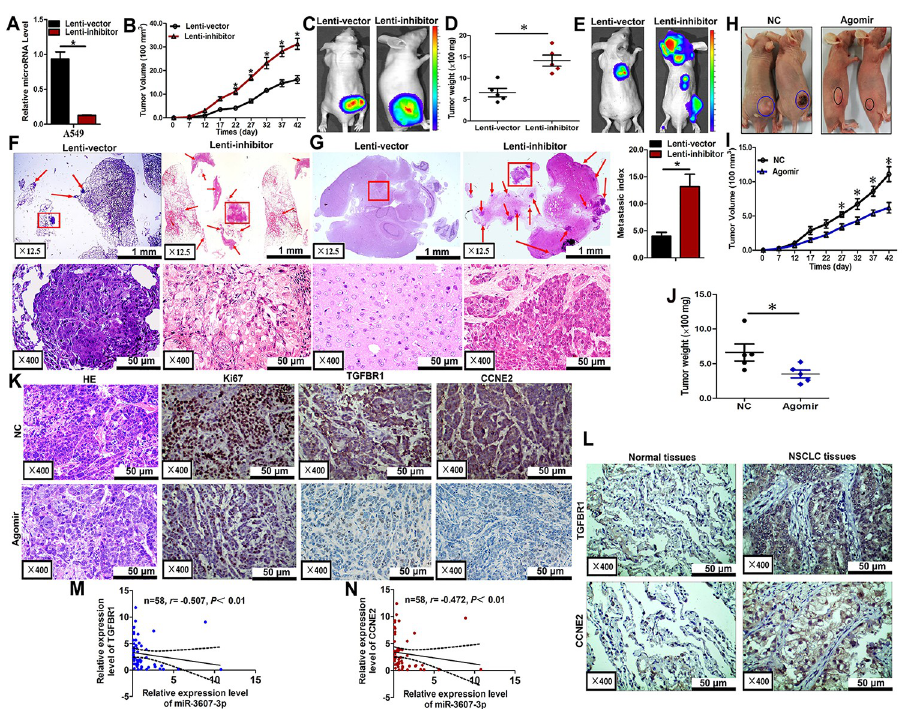
Fig 7. miR-3607-3p suppressed tumor growth and metastasis in vivo . (A) Levels of miR-3607-3p in stable miR- 3607-3p knockdown A549 cells (Lenti-inhibitor) and control A549 cells (Lenti-vector). (B-D) Stable miR-3607-3p knockdown A549 cells were subcutaneously injected into nude mice to form solid tumors and representative images of tumor volumes and weights were analyzed by in vivo luciferase imaging on the endpoint day (n = 5 for each group). (E-G) The numbers of metastatic nodules were observed and quantified in the lungs and brain of mice treated with stable miR-3607-3p knockdown A549 cells or control vector cells by tail vein injection. (H-J) The A549 cells were subcutaneously injected into nude mice to form solid tumors and were treated with miR-3607-3p agomir or miR agomir NC (n = 5 for each group). A 10-nmol miR-3607-3p agomir and the miRNA negative control in 0.1 ml saline buffer were locally injected into the tumor masses once every 5 days for 6 weeks. (K) Immunohistochemistry of Ki67, TGFBR1, and CCNE2 in tumor tissues dissected from nude mice treated with miR-3607-3p agomir or miR angomir NC. (L) TGFBR1 and CCNE2 protein expression measured by immunohistochemistry in 162 NSCLC samples and association with lung cancer survival. (M-N) Spearman correlation analysis of the negative correlation between the expression of miR-3607-3p and TGFBR1/ CCNE2. � , P <